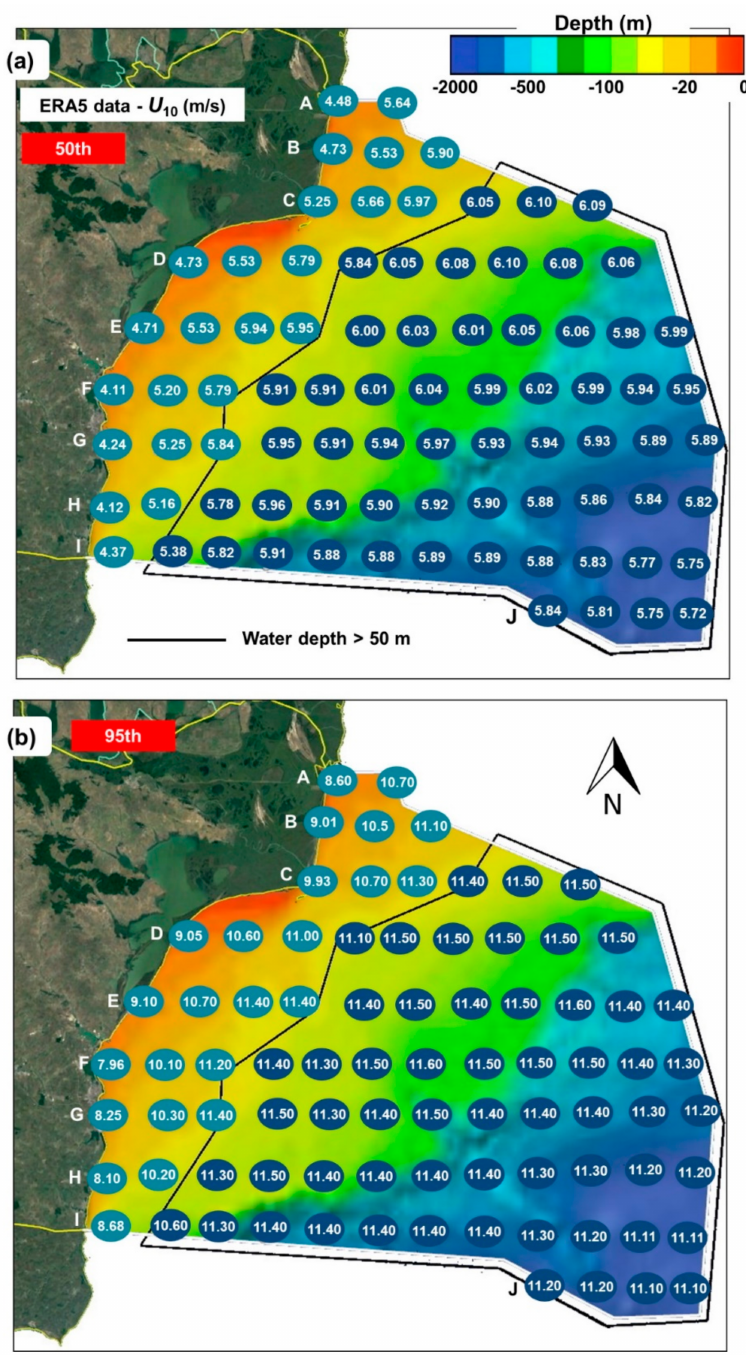
Figure 3. Percentiles distribution corresponding to the ERA5 ( U 10 ) reanalysis data for the 20-year time interval 2000–2019. The results are indicated in terms of: ( a ) 50th percentile; and ( b ) 95th